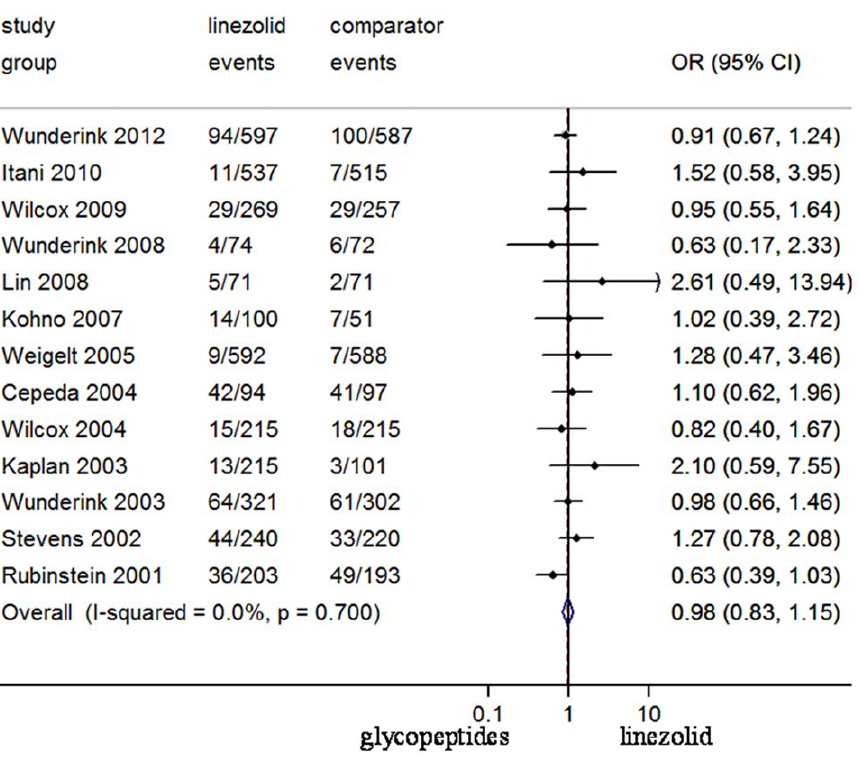
Figure 7. Meta-analysis of mortality in this pooled data. Test of mortality for overall effect: Z=0.29 P =0.771.